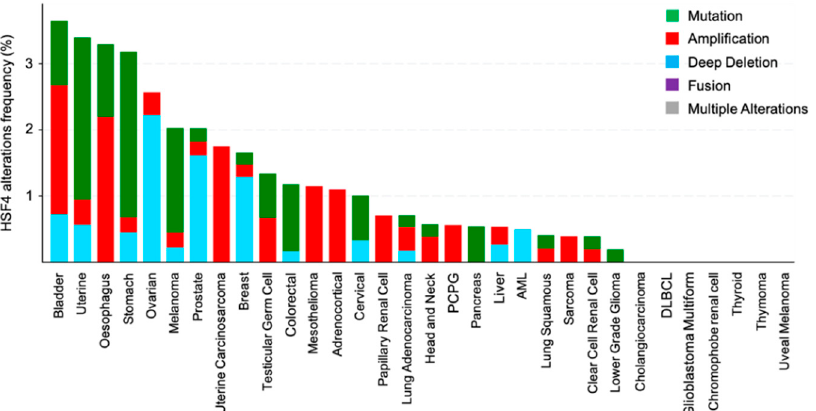
Figure 6. The frequency of HSF4 genetic alterations in thirty-two different cancer types characterized in the large scale Cancer Genome Atlas project. The identified genetic alterations in HSF4 include mutation, amplification, deep deletion, and fusion. These HSF4 genetic alterations frequency data were queried and extracted using cBioPortal (https://www.cbioportal.org/, accessed on 9 January 2021).